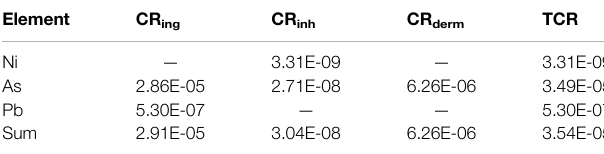
TABLE 7 | Carcinogenic health risks of heavy metals in Lushan scenic area.